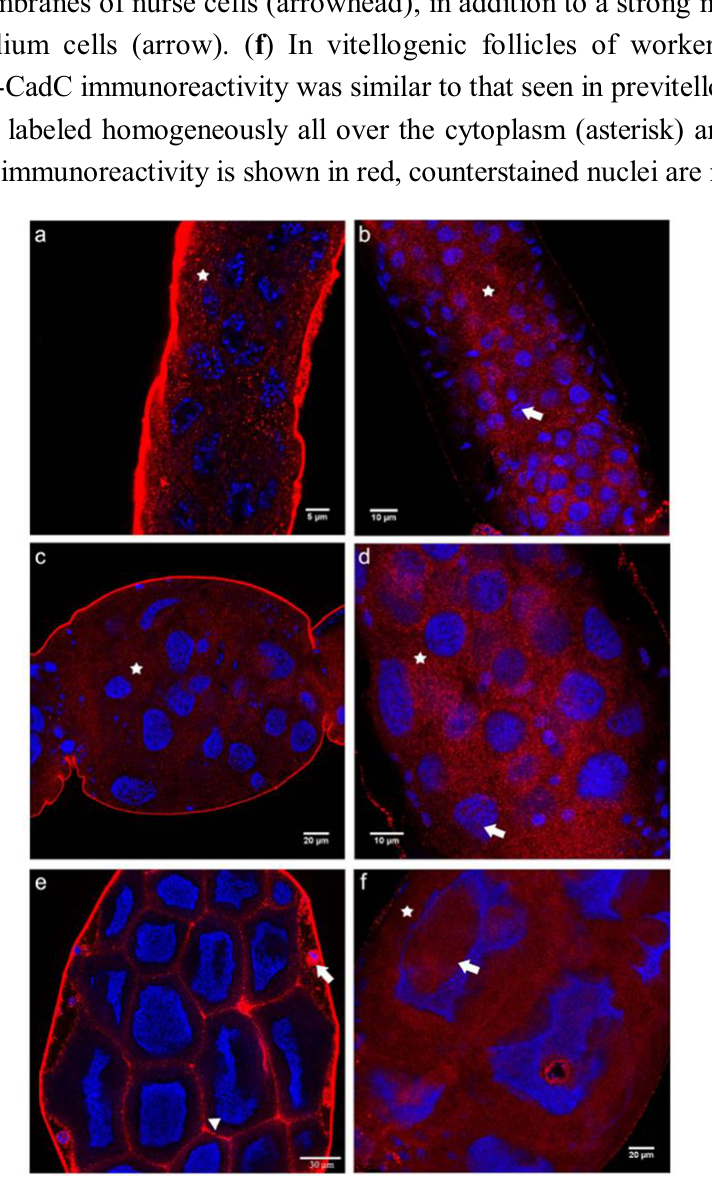
Figure 4. Immunofluorescence analysis with an antibody raised against the C-terminal domain of N-cadherin (N-cadC) performed on ovaries of egg-laying queens ( a , c and e